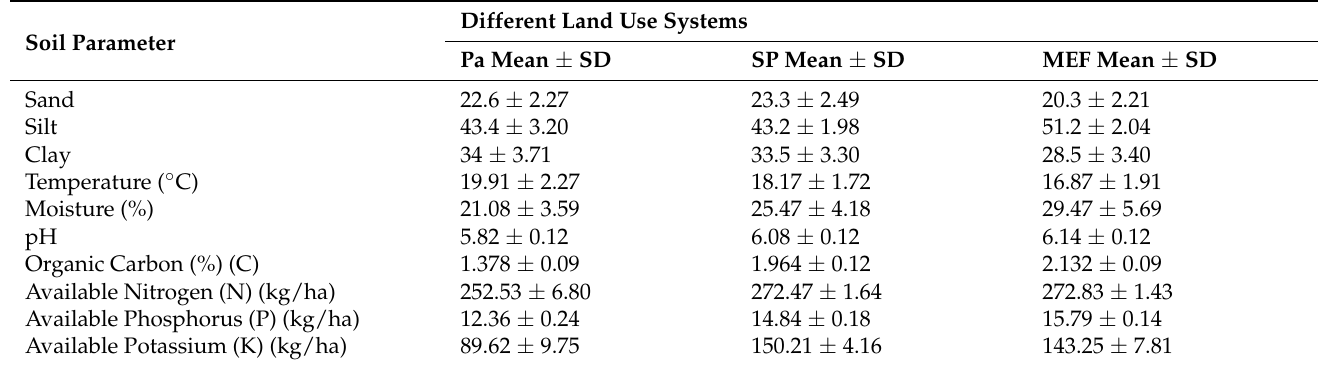
Table 3. Overall seasonal variation of soil physicochemical parameters in different land use types.